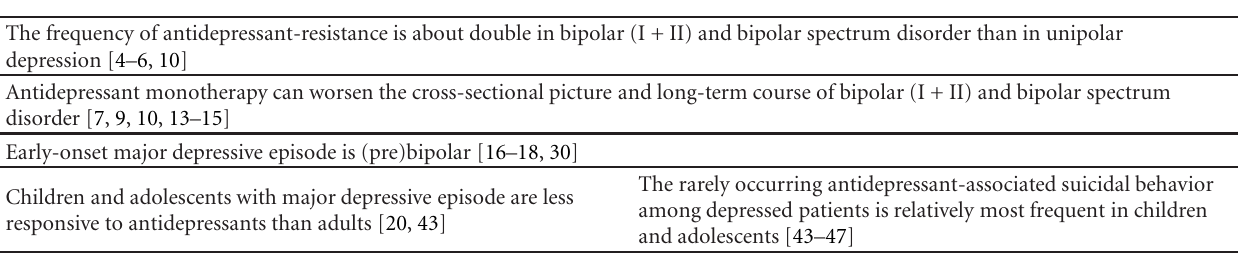
Table 1: The role of underlying bipolarity in antidepressant-resistance and antidepressant-associated suicidality in patients with mood